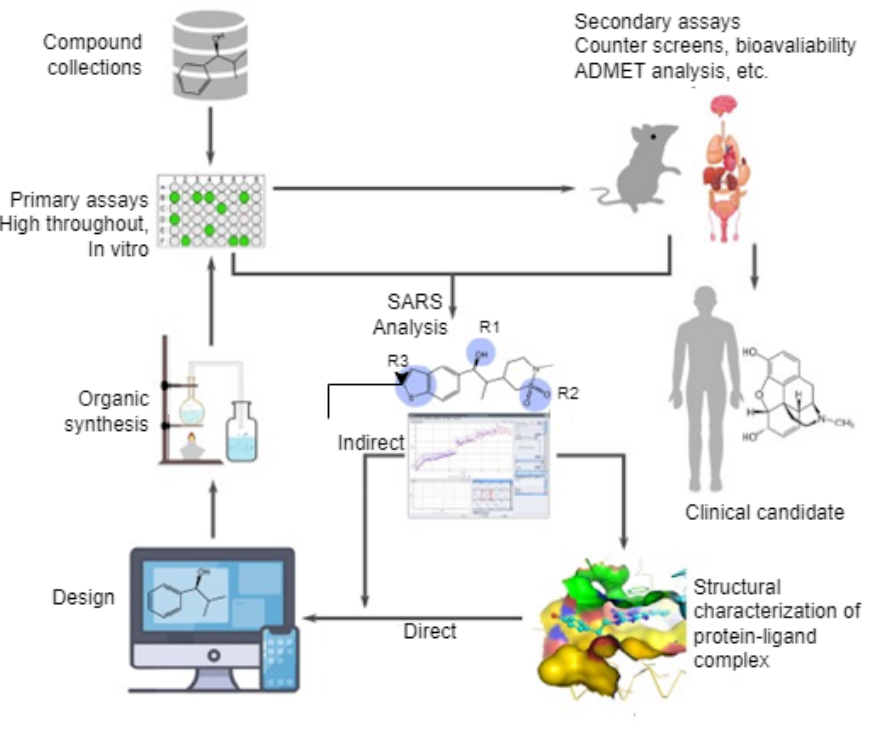
Figure 3. A pipeline of drug discovery and development